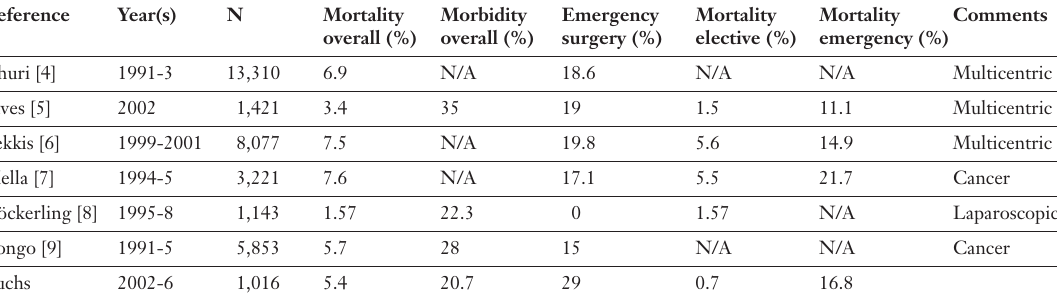
patients.No financial support